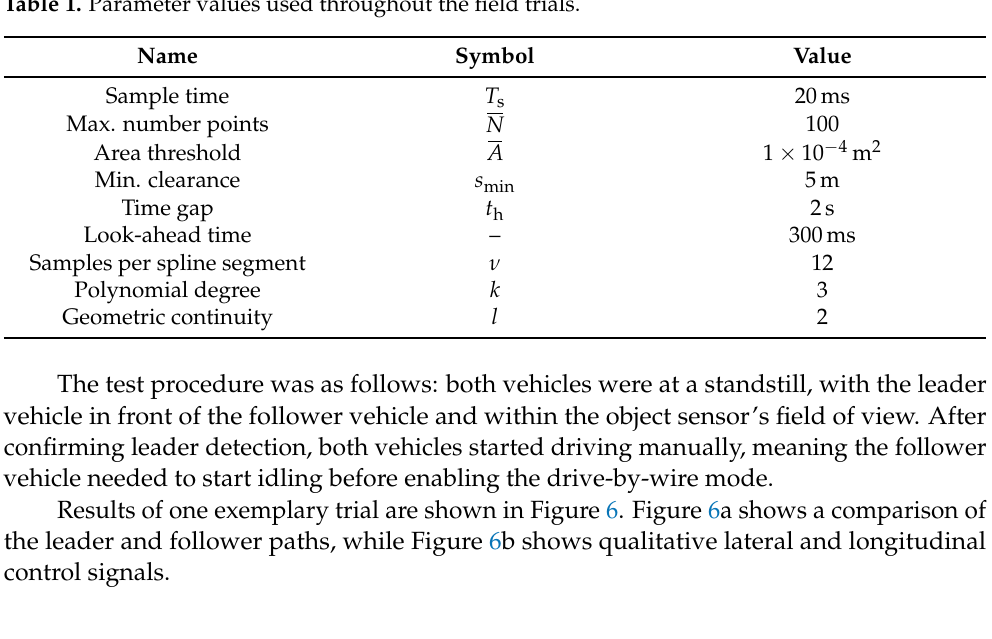
Table 1. Parameter values used throughout the field